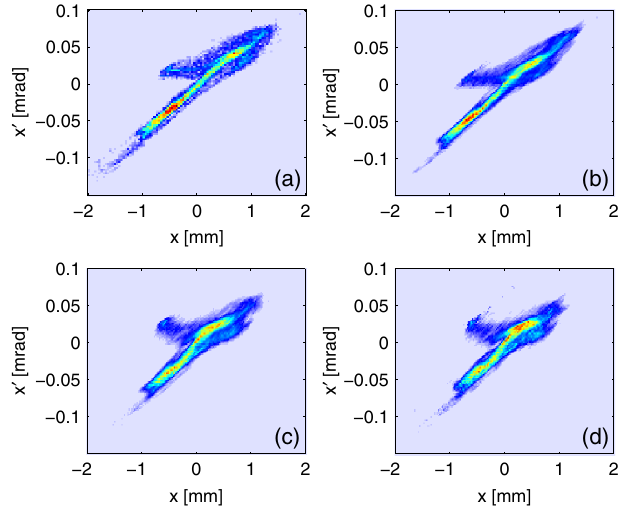
FIG. 5. (Color) Tomographic reconstruction of a simulated par- ticle distribution. (a) Horizontal phase space of the bunch head at the reconstruction point s ¼ s R as predicted by a start-to-end simulation of the FLASH linac under FEL operating conditions (beam energy E ¼ 494 MeV , bunch charge Q ¼ 0 : 72 nC ).